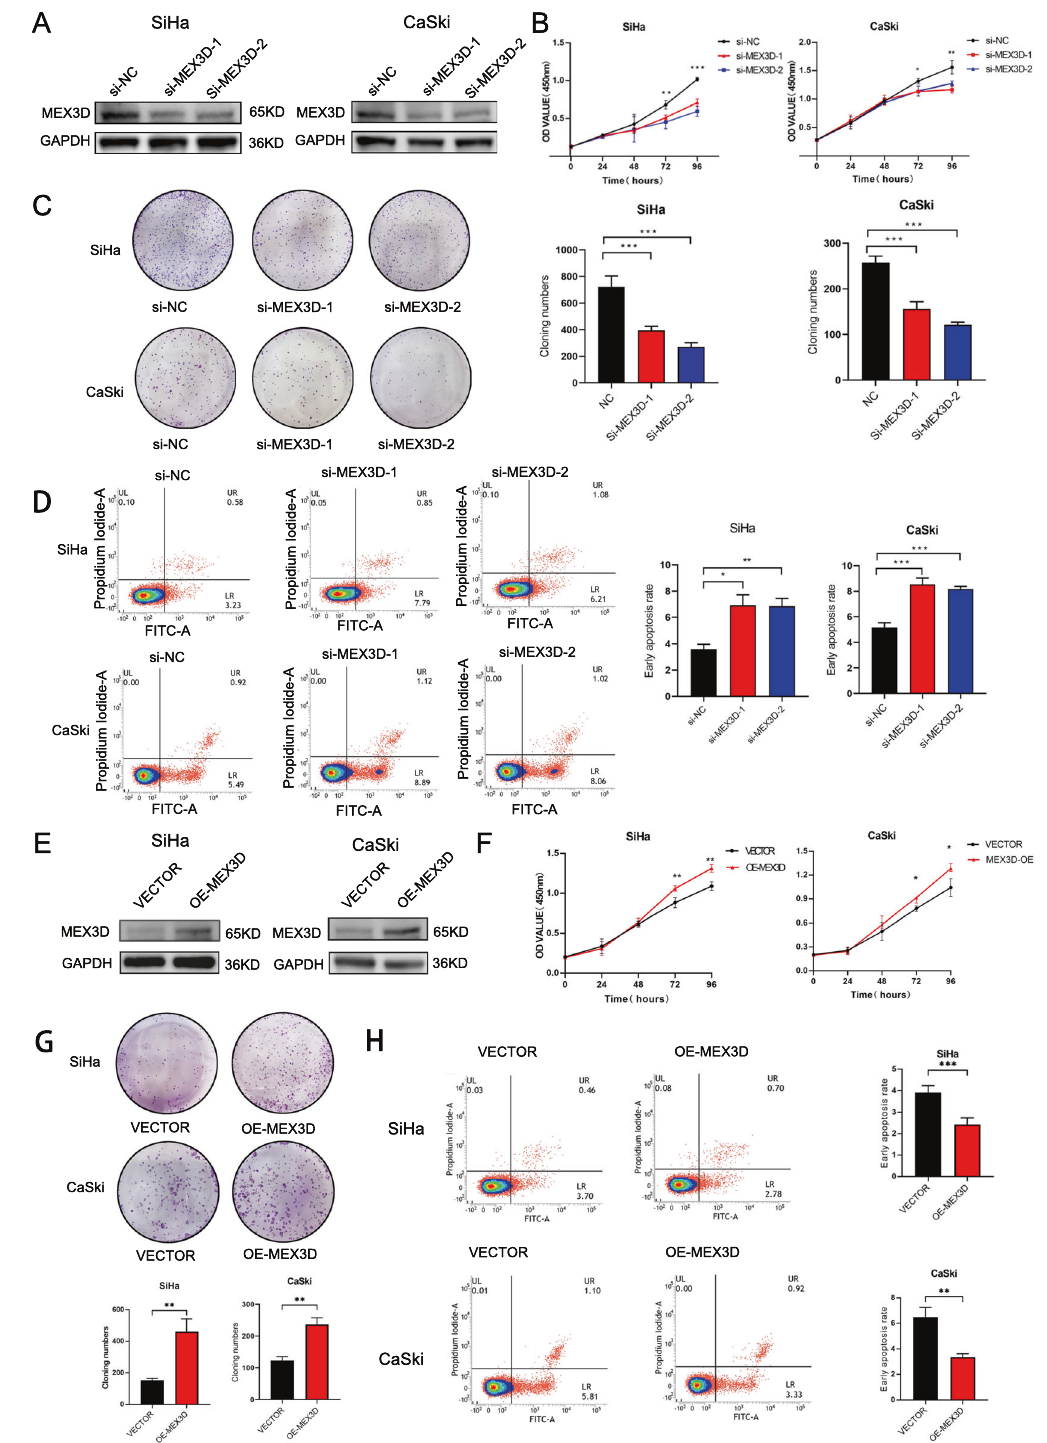
Fig. 2 MEX3D stimulates cervical cancer cells proliferation whereas inhibits its apoptosis. A Western blot analysis was utilized for estimating MEX3D protein expression levels in CaSki and SiHa cells after being transfected with a negative control siRNA or two MEX3D- speci fi c siRNAs. B The growth curve in CaSki and SiHa cells was estimated through CCK8 assays after being transfected with a negative control siRNA or two MEX3D-speci fi c siRNAs. C Knockdown of MEX3D with two MEX3D-speci fi c siRNAs suppressed cell viability shown by colony formation in CaSki and SiHa cells. D Apoptosis level in CaSki and SiHa cells after being transfected with two MEX3D-speci fi c siRNAs or a negative control siRNA. E Western blot was utilized for determining the levels of MEX3D overexpression in CaSki and SiHa cells utilizing a constructed and control plasmid. F – H MEX3D overexpression stimulated cellular proliferation ( F , G ) whereas the suppressed rate of cellular apoptosis in CaSki and SiHa cells ( H ). * P < 0.05, ** P < 0.01, *** P < 0.001.